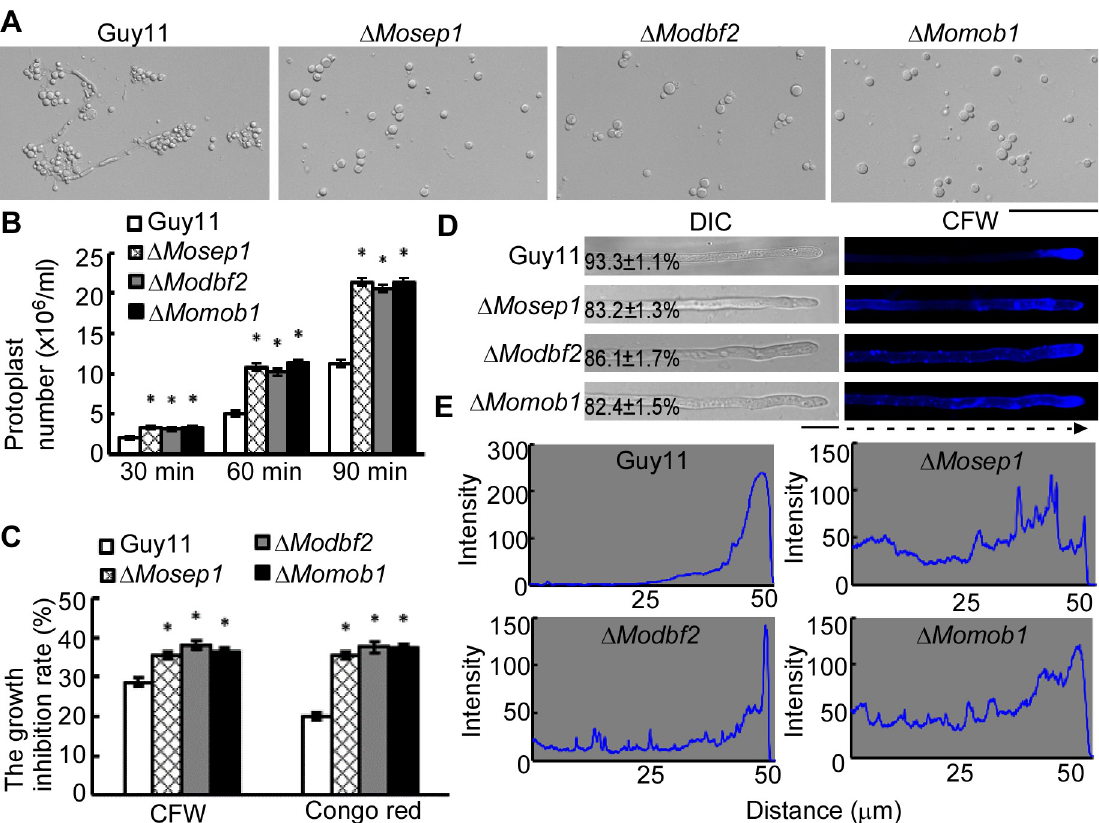
Fig 6. Disruption of MEN results in defects in CWI signaling. (A) Light microscopic examination of protoplast release of Guy11, Δ Mosep1 , Δ Modbf2 , and Δ Momob1 mutants after treatment with cell wall-degrading enzymes for 45 min at 30˚C. Bar, 50 μ m. (B) Statistical analysis of protoplast release of Guy11, and the Δ Mosep1 , Δ Modbf2 , Δ Momob1 mutants after treatment with cell wall-degrading enzymes for 30 min, 60 min, and 90 min at 30˚C. Error bars represent the standard deviations from three independent experiments. Asterisks indicate statistical significance according to a Student’s test (p < 0.01). (C) The hyphal diameter of Guy11, Δ Mosep1 , Δ Modbf2 , and Δ Momob1 mutants examined 7 days after incubation on CM agar plates with different cell wall-perturbing agents including 400 μ g/ml for CFW, and 400 μ g/ml for Congo red. The experiments were repeated three times. Error bars represent the standard deviations from three independent experiments. Asterisks indicate statistical significance according to a Student’s test (p < 0.01). (D) Observation of chitin in the cell wall. Hyphae of Guy11, Δ Mosep1 , Δ Modbf2 , and Δ Momob1 mutants were stained with CFW for 5 min in darkness. Bar, 10 μ m. CFW is widely used to stain cell wall chitin in fungi. (E) Linescan graph analysis of chitin stained with CFW of